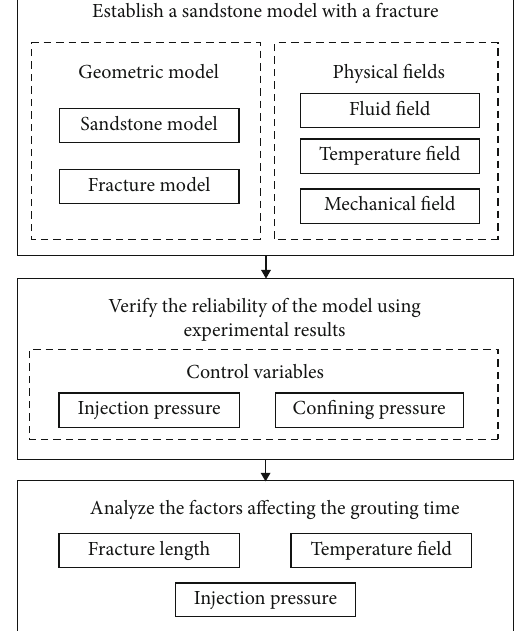
Figure 1: Flowchart of the numerical study on seepage of chemical grout fl ow in rock fracture under temperature fi eld.